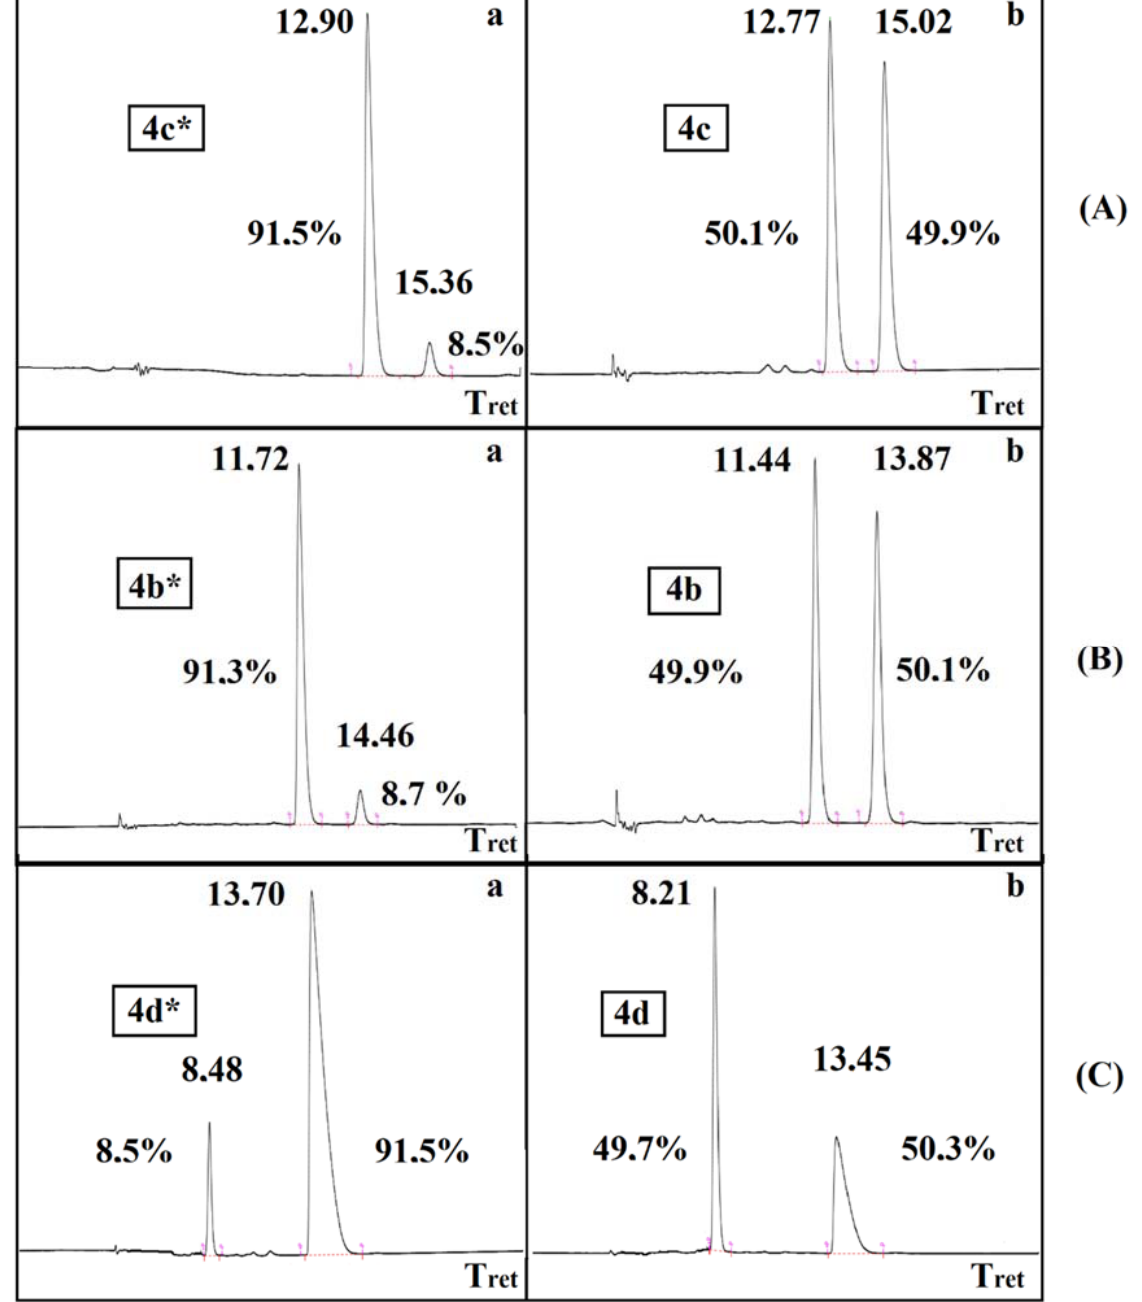
Figure 1. Chiral HPLC chromatograms Aa , Ba , Ca and Ab , Bb , Cb for the optically active 4c* , 4b* , 4d* α‐ hydroxyphosphonates and for the racemic 4c , 4b , 4d derivatives, respectively.